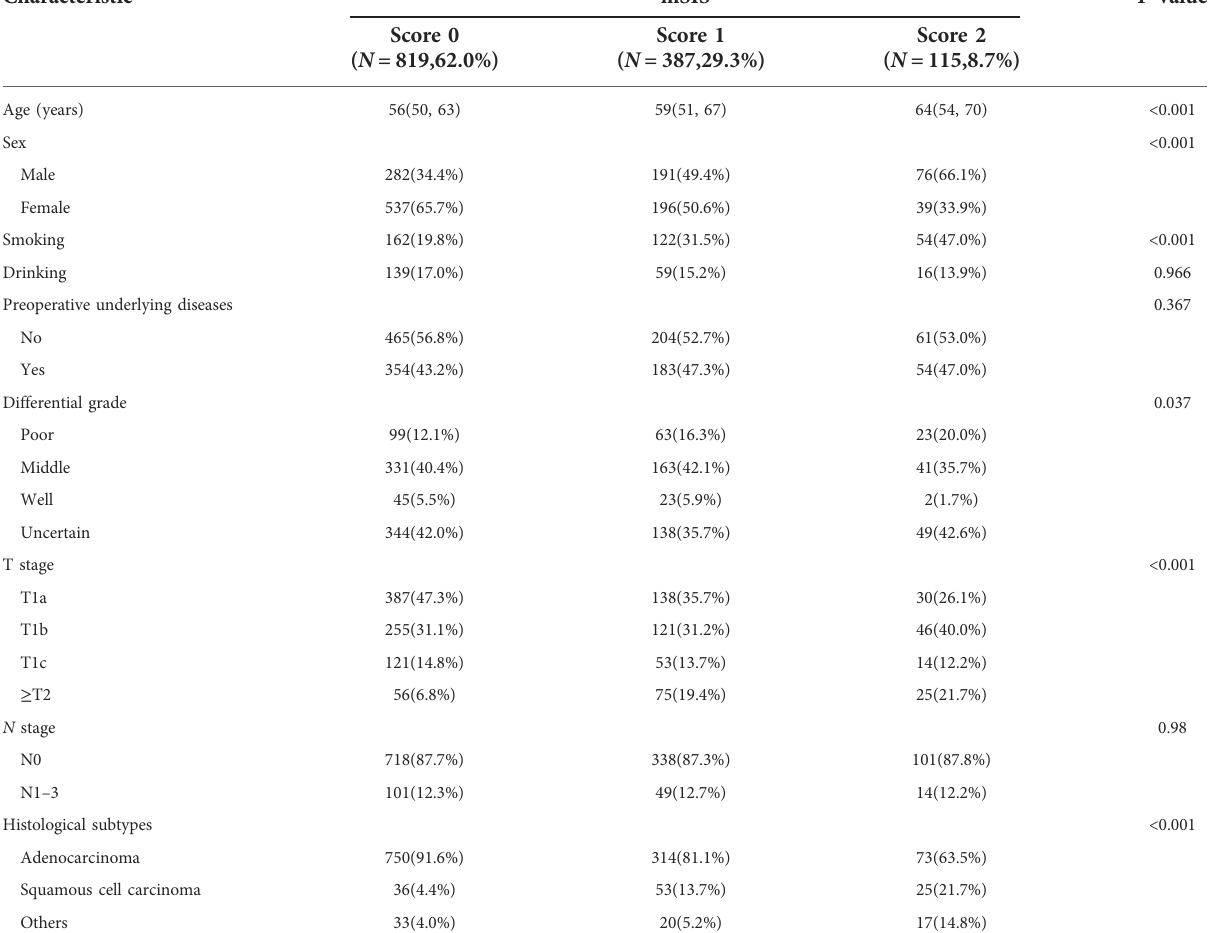
TABLE 2 Characteristics of mSIS classi fi cation in surgical patients with